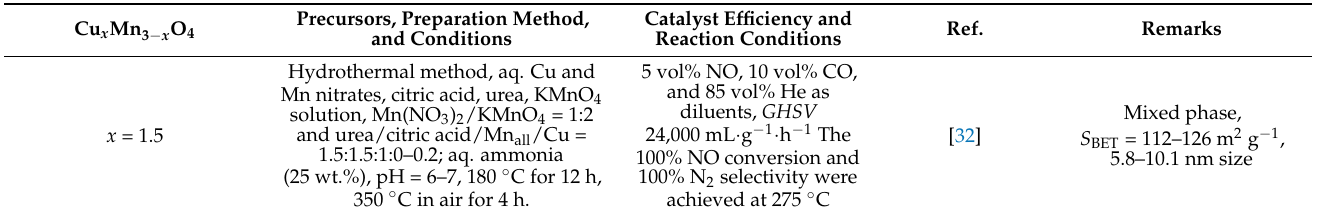
Table 5. Copper manganese oxide spinel catalysts and their activity in NO oxidation reactions.